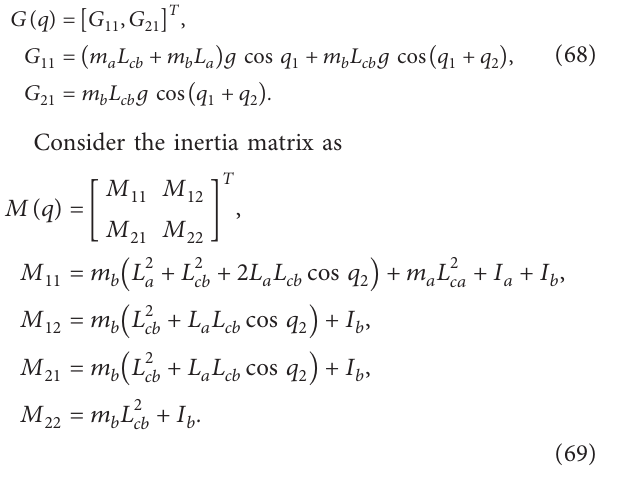
Figure 1: Trajectories of x